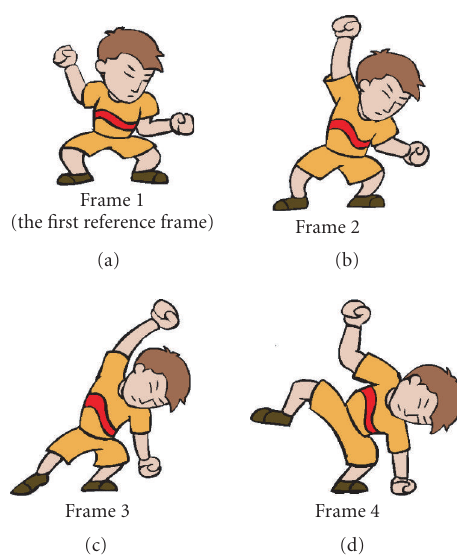
Figure 11: Test 2 (resolution: 550 × 400 pixels).